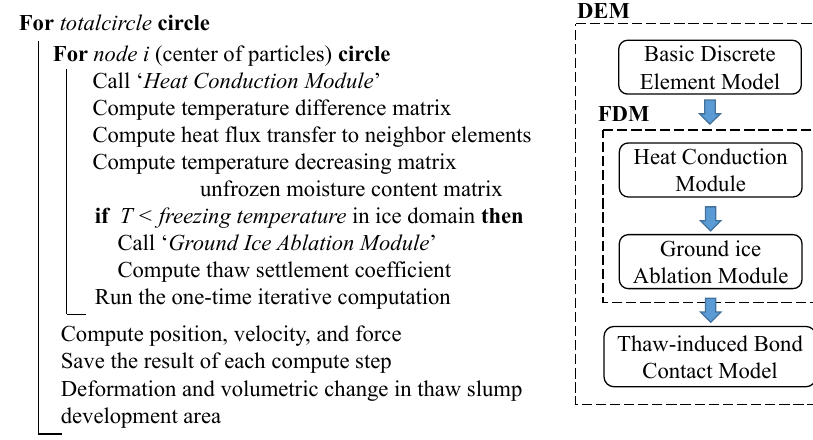
10 of 19 Figure 6. Basic discrete element model ( a ), details of the headwall ( b ), and the three-dimensional point cloud model ( c ) of the K1129W thaw slump. The flow chart (Figure 7) illustrates the specific implementation processes of cou- pling the aforementioned computation modules in this discrete element model. The de- tailed simulation procedure is described in the following steps. Firstly, based on the fi- nite difference method (FDM), we generated the temperature differences matrix of the thermal disturbance elements and their neighboring elements. Additionally, the heat